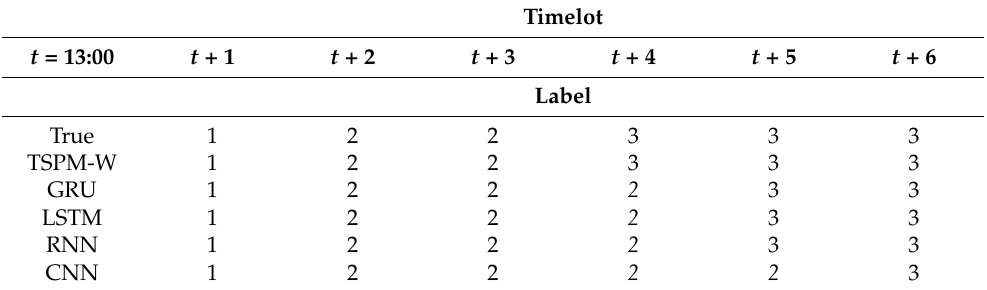
Table 11. Traffic situations’ prediction (Feature combination 3) for 7th December 2018 13:00 to